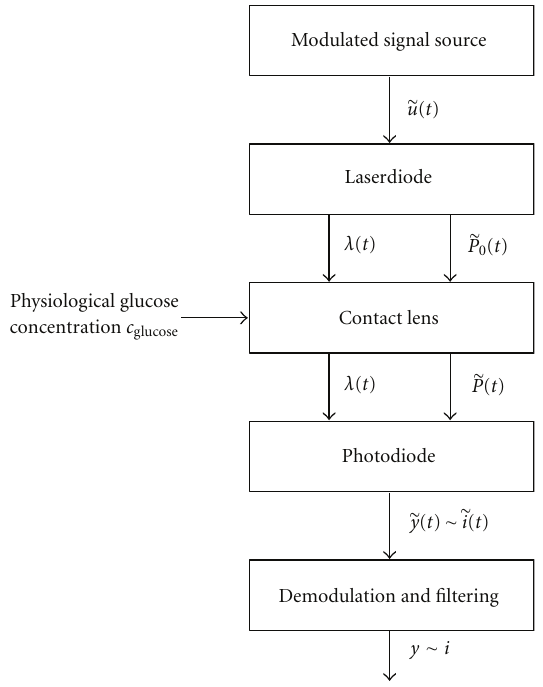
Figure 4: Block diagram used for simulation including signal proc- essing scheme and embedded metamaterial model.